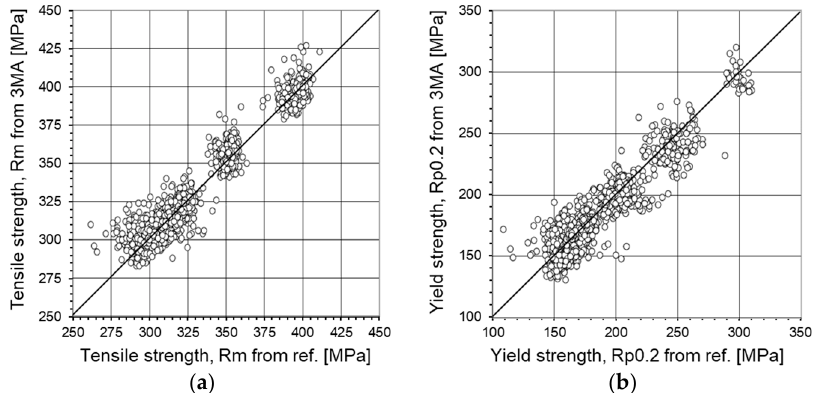
Figure 10. Results of the verification of the calibration; comparison of the values from 3MA measurements with destructively measured values: ( a ) for tensile strength, Rm and ( b ) for yield strength, Rp0.2.